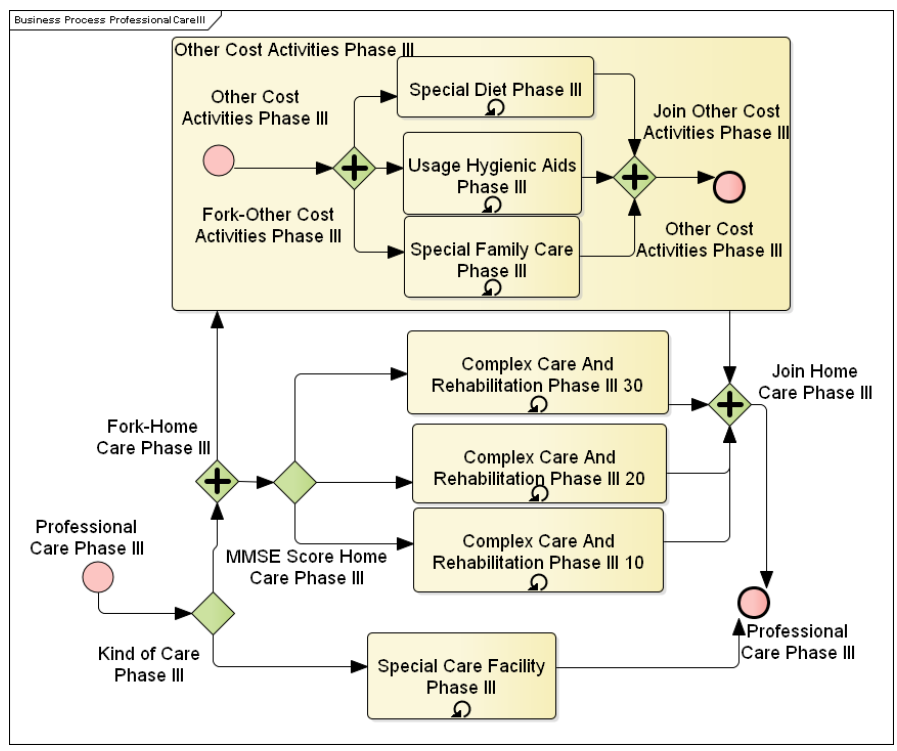
Figure 8. BPMN subprocess of Alzheimer’s disease in Phase